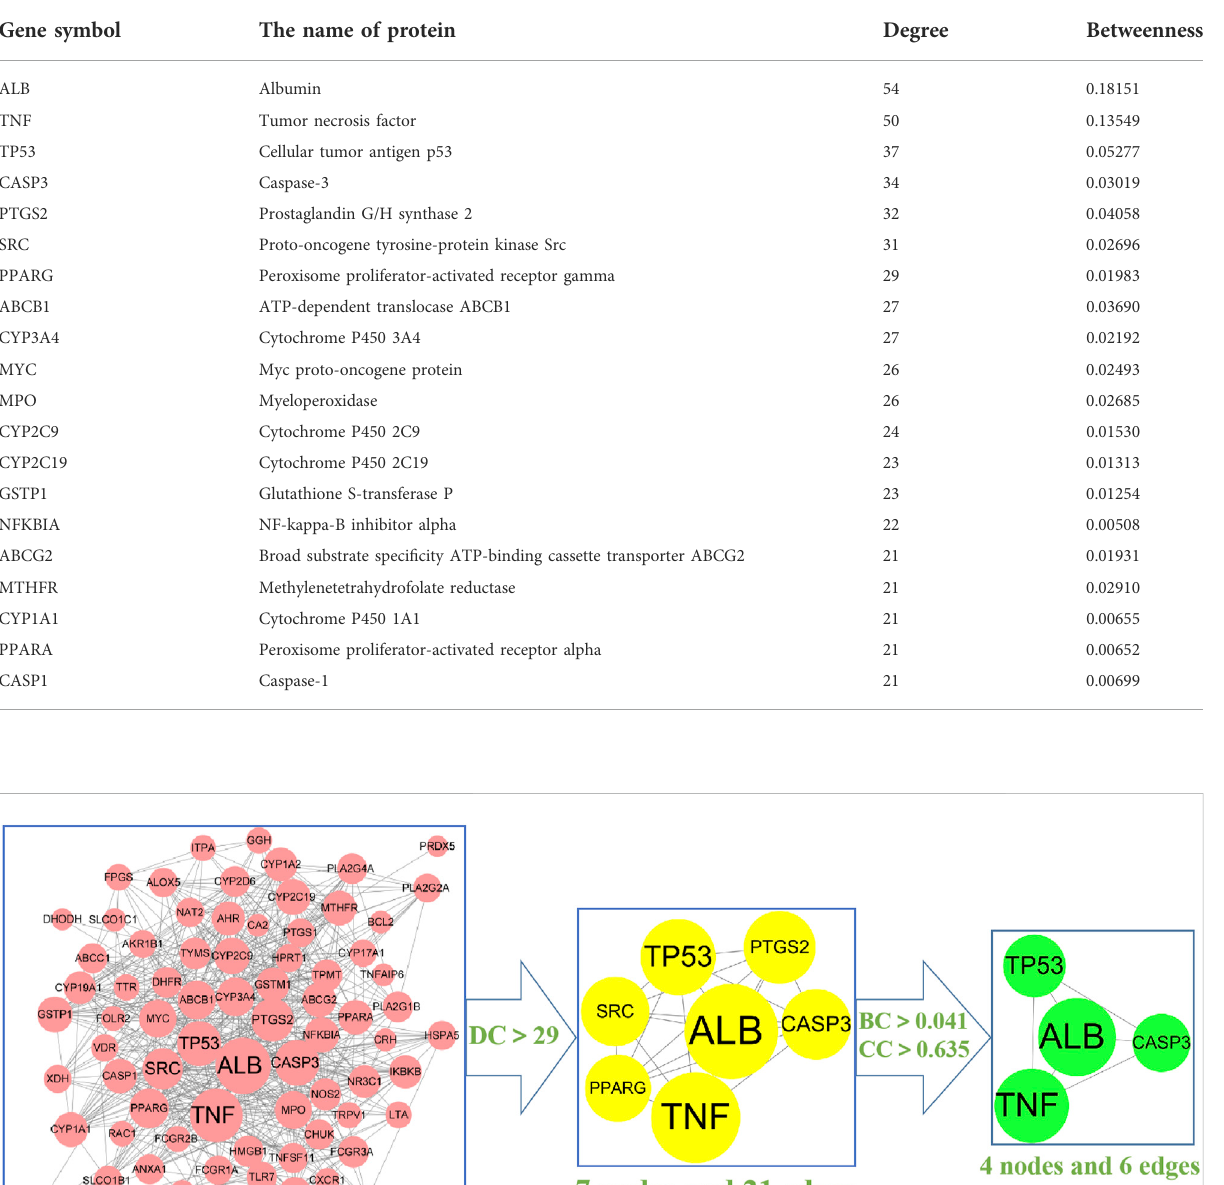
TABLE 1 The top 20 targets in PPI.